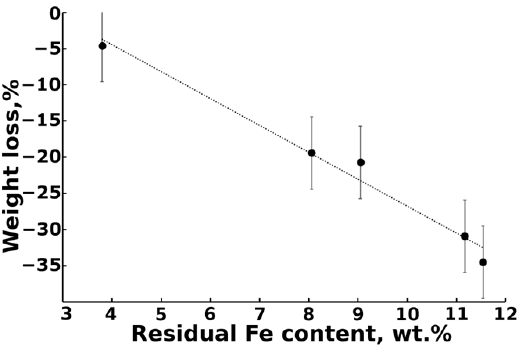
Figure 6. Dependence of weight losses during heat treatment of samples under static air atmosphere on residual iron content.